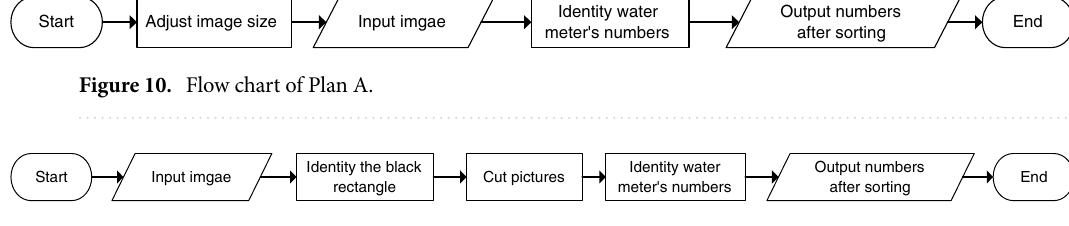
Figure 11. Flow chart of Plan B.